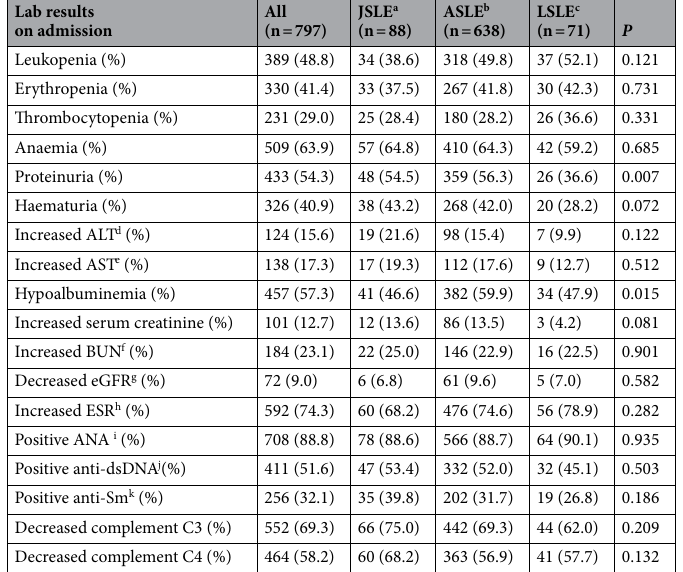
Table 4. Laboratory findings among different age-onset groups. a JSLE juvenile-onset SLE; b ASLE adult-onset SLE; c LSLE late-onset SLE; d ALT alanine aminotransferase; e AST aspartate aminotransferase; f BUN blood urea nitrogen; g eGFR estimated glomerular filtration rate; h ESR erythrocyte sedimentation rate; i ANA , anti-nuclear antibody; j anti-dsDNA anti-double-stranded deoxyribonucleic acid antibody; k anti-Sm anti-Smith